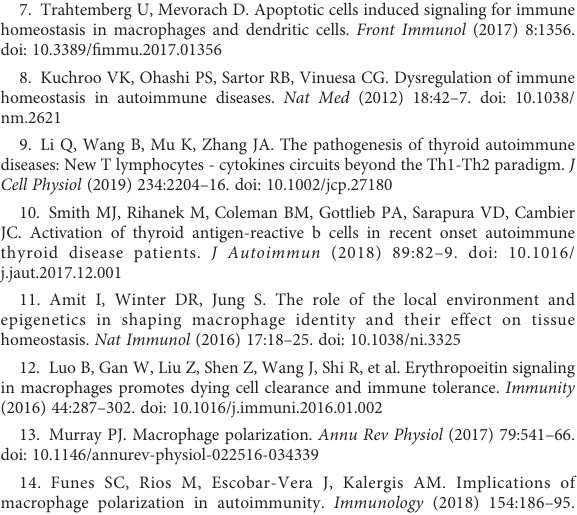
polarization induced by IL-4 in GSE123603(From left to right: M1 and M2; M1: ES=0.31, P=0.67, FDR q=0.68; M2: ES=0.93, P<0.001, FDR q <0.001); (C) Enrichment plots of mice macrophage polarization gene sets in the GSEA analysis of mice M1 polarization induced by LPS in GSE123180(From left to right: M1 and M2; M1:ES=0.89,P<0.001, FDR q <0.001; M2: ES=0.35, P=0.36, FDR q=0.37); (D) Enrichment plots of mice macrophage polarization gene sets in the GSEA analysis of mice M2 polarization induced by IL-4 in GSE123180 (From left to right: M1 and M2; M1: ES= -0.62, P<0.001, FDR q <0.001;M2: ES=0.92,P<0.001, FDR q <0.001).